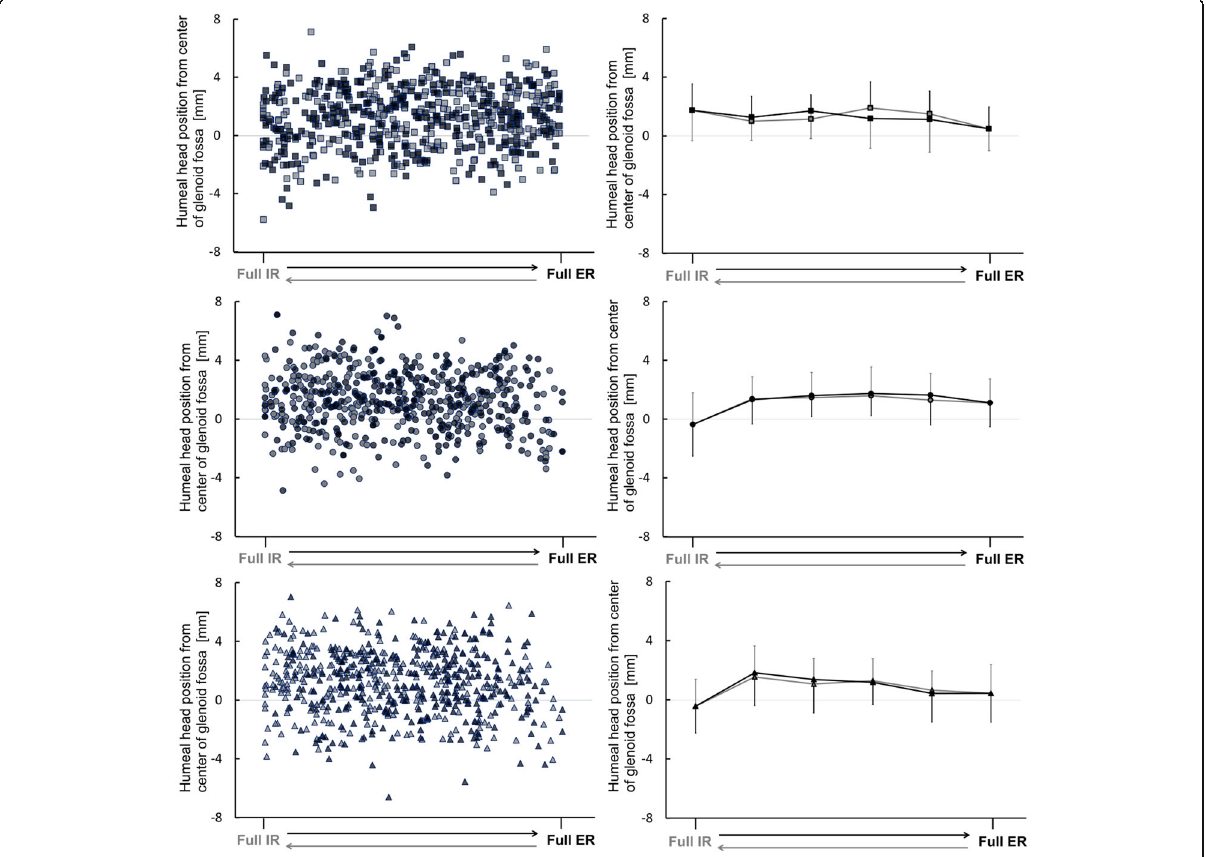
Fig. 2 Distribution of humeral head position (the left scatter plot graphs) and mean value of humeral head position (the right line graphs). X-axis represents shoulder rotation (Full IR: Full internal rotation; Full ER: Full external rotation). Y-axis represents the humeral head position from the center of the glenoid fossa (mean ± SD mm). Square markers (top row) are for low velocity. Round markers (middle row) are for medium velocity. Triangular markers (bottom row) are for high velocity. The darker markers and lines represent IR and the lighter markers and lines represent ER